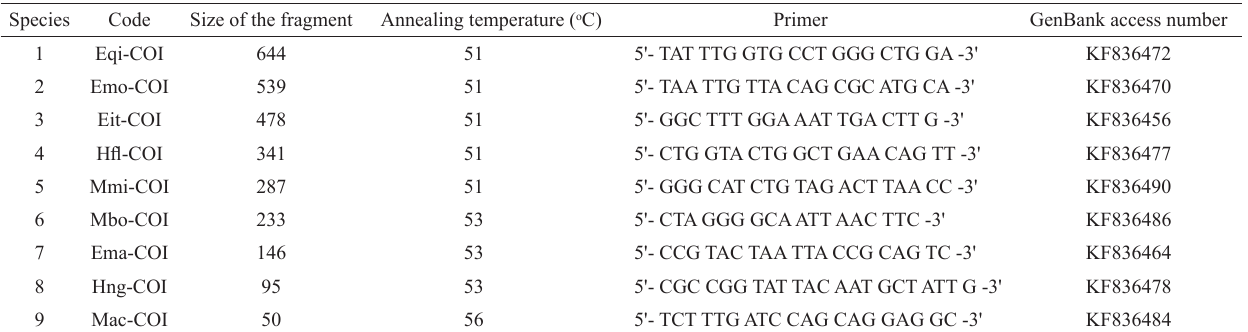
Table 1. Species-specific primers developed for the present study, the size of the fragments isolated, and the GenBank accession numbers of the sequences obtained for the nine grouper species of the family Epinephelidae. 1. Epinephelus quinquefasciatus 2. Epinephelus morio 3. Epinephelus itajara 4. Hyporthodus flavolimbatus 5. Mycteroperca